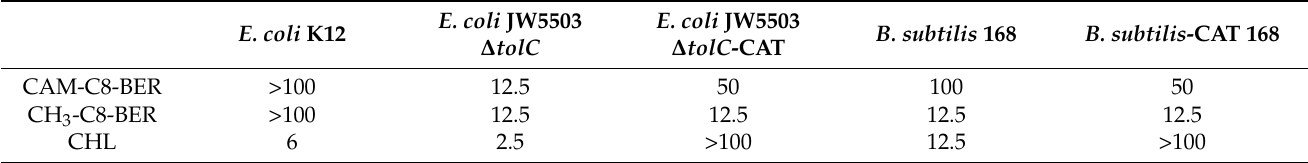
Table 1. Suppression of the growth of E. coli and B. subtilis strains, including CHL-resistant ones, by CAM-C8-BER. CH 3 -C8-BER and CHL were used as controls. The values of a minimal inhibitory concentration (MIC, µ M) are shown 1 .